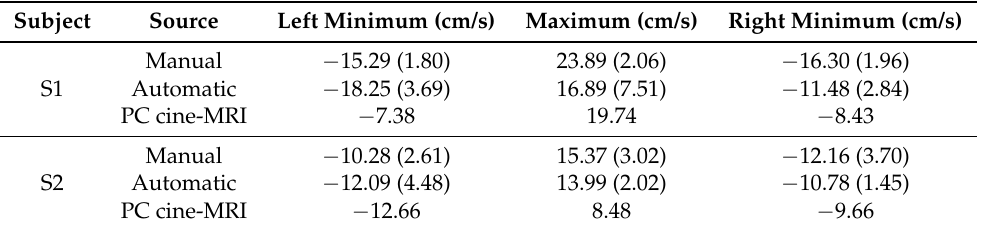
Table 1. Mean (std. dev.) of the peak velocity values.